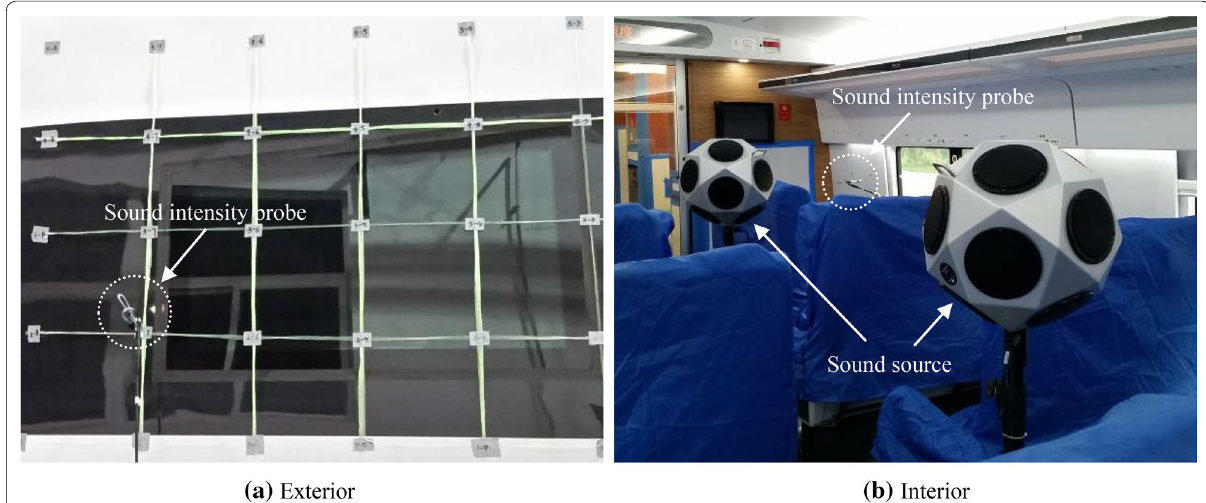
Figure 15 Photographs of the airborne sound transmission loss measurement